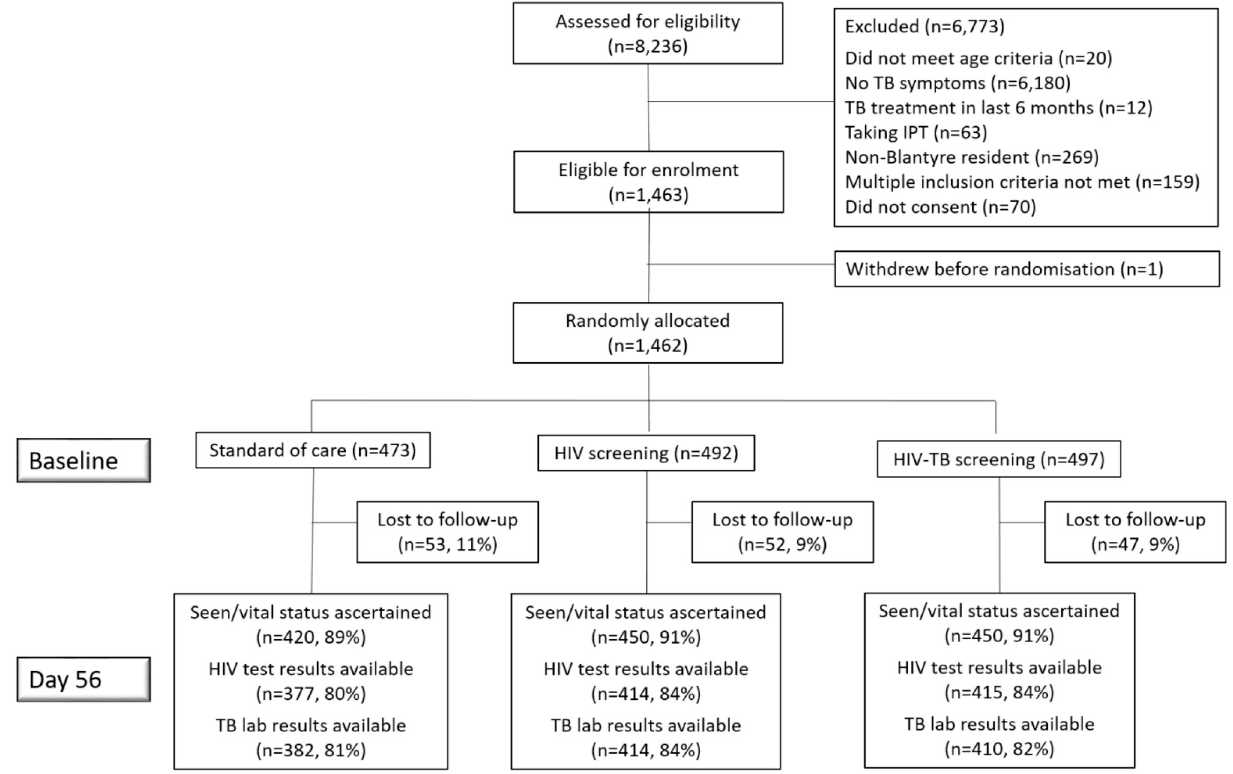
Fig 1. Trial profile. IPT AU : AbbreviationlistshavebeencompiledforthoseusedinFigs 1 (cid:0) 3 : Pleaseverifythatallentriesarecorrect : , isoniazid preventive therapy; TB, tuberculosis.